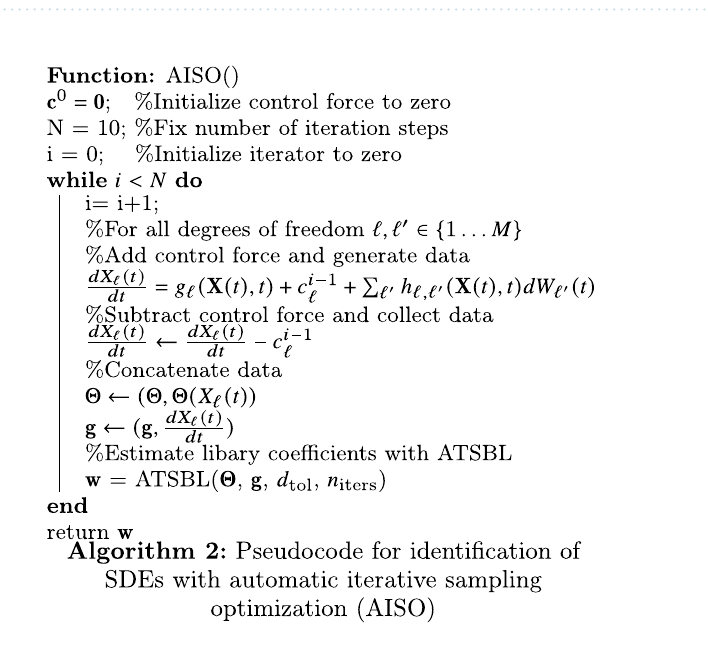
Figure 5. Demonstration of data-driven discovery of PDEs with ATSBL using a reaction–diffusion system. 0.3 . ( a-i , ii ) Snapshots of the initial conditions for the variables u and v , respectively. ( a-iii , iv ) u and v at time t = ( b ) The table shows the original PDEs for the reaction–diffusion system and the identified PDEs for noise-free data and data with 2% Gaussian noise. Inference is conducted with a library containing 35 terms. The numerical 0, 0.6 0.0034 in the time interval t calculations are done with a time step (cid:31) t . The space domain has size = [ ] = 20 20 and is covered with a 256 256 grid with periodic boundary × ×